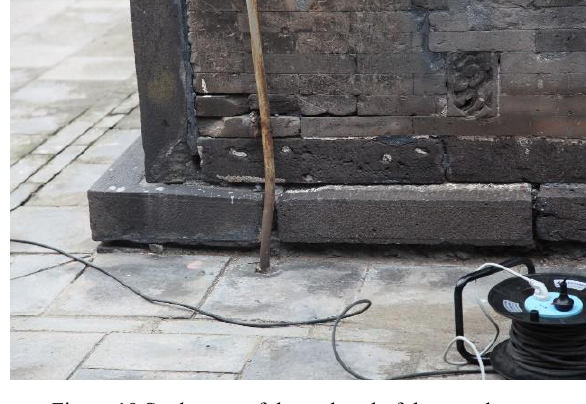
Figure 19 Settlement of the pedestal of the temple gate